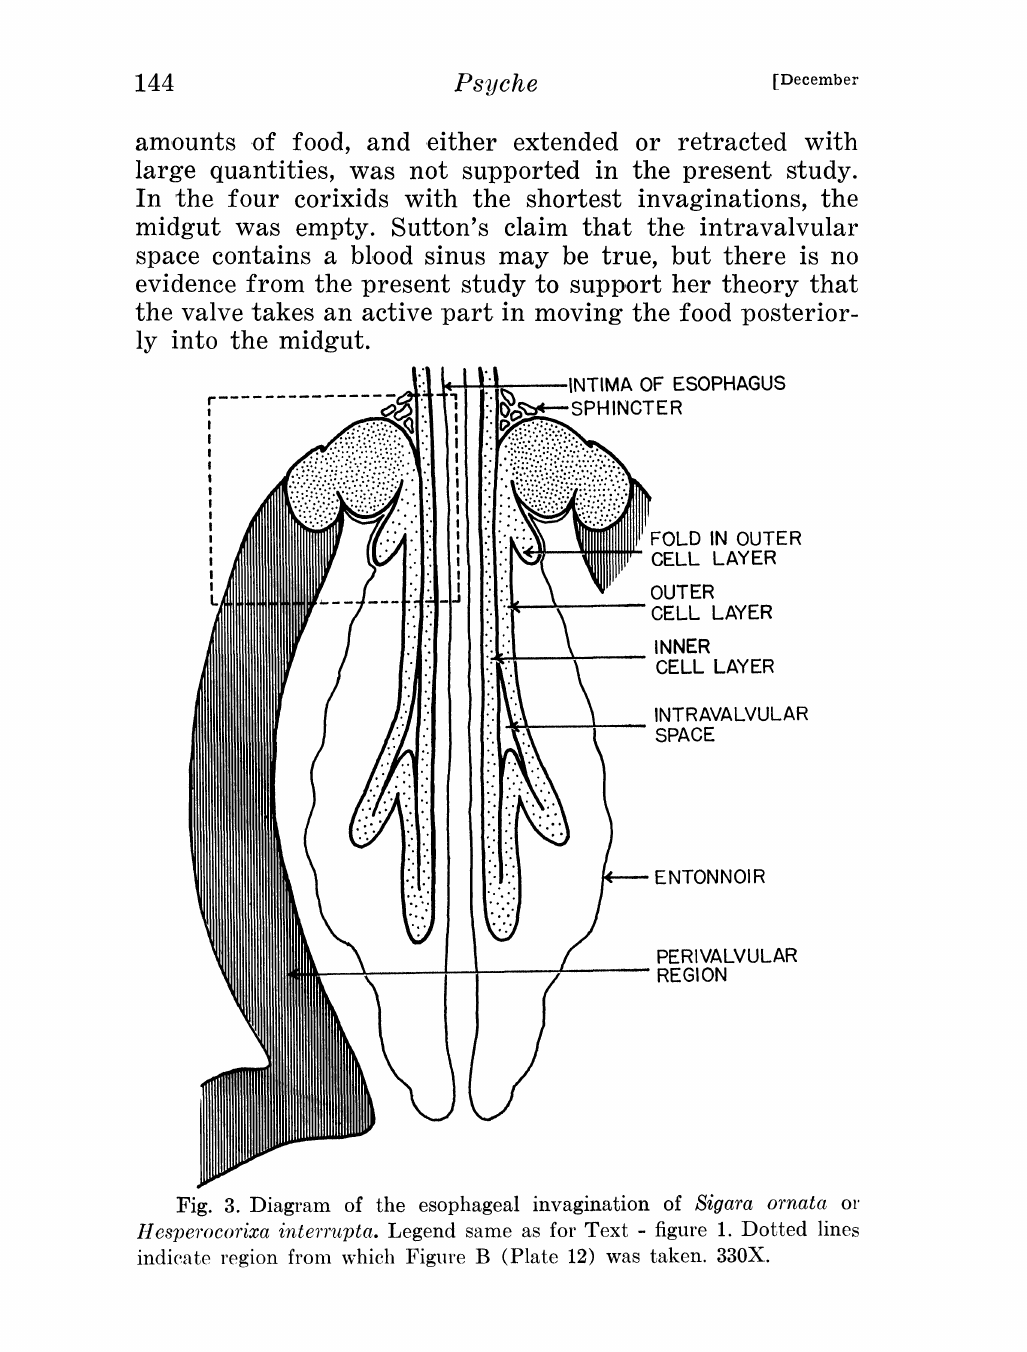
Fig. 3. Diagram of the esophageal invagination of Sigara ornata or Hcsperocorixa interrupta. Legend same as for Text figure 1. Dotted lines indicate region from which Figure B (Plate 12) was taken.